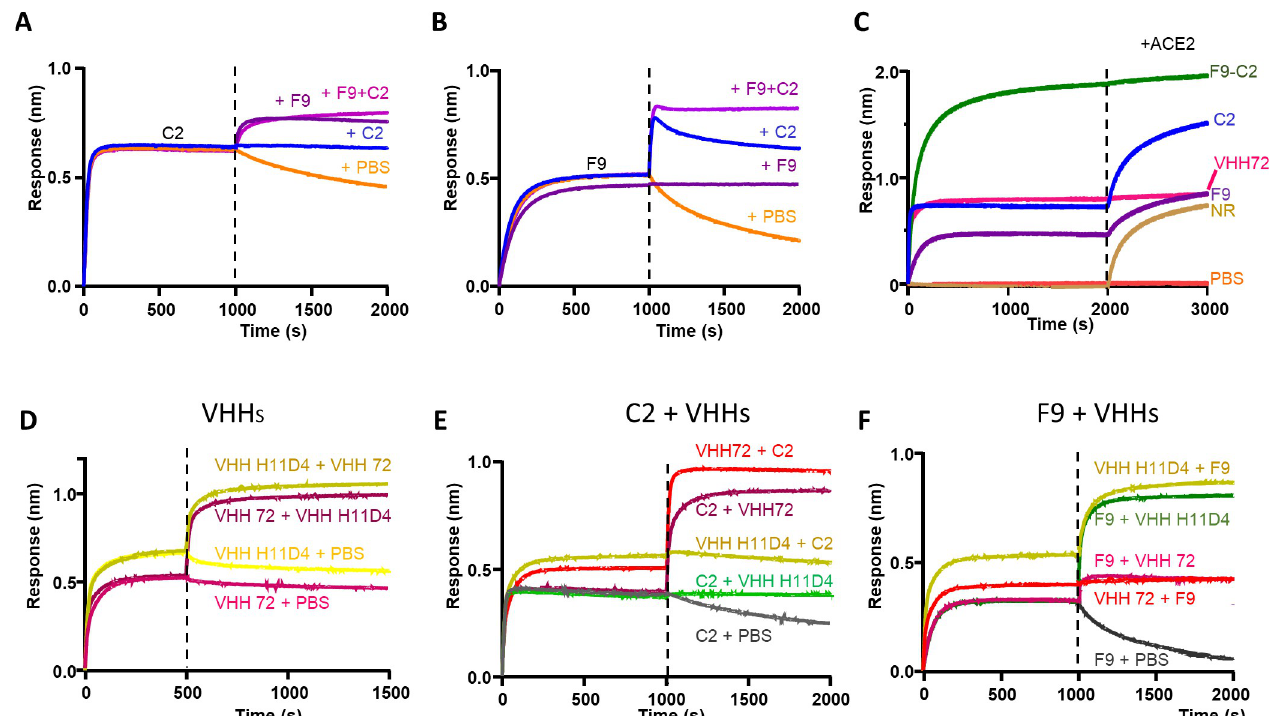
Fig 3. Competitive binding assays. (A and B) BLI experiments showed that C2 and F9 could bind RBD simultaneously. (C) Binding of ACE2 was assessed after a first association phase with α Reps C2 and F9, the F9-C2 construct, the VHH72 [19] or with a negative control (NR). F9-C2 and VHH-72 blocked the binding of RBD to ACE2. While F9 inhibited partially ACE2 binding, C2 did not compete with ACE2 binding. (3D-F) Reciprocal competitive binding assays between VHH-72, VHH H11D4, C2 and F9. While C2 and H11D4 competed for binding to the RBD (immobilized on the chip) in a reciprocal manner, F9 and VHH-72 blocked reciprocally their interaction to the